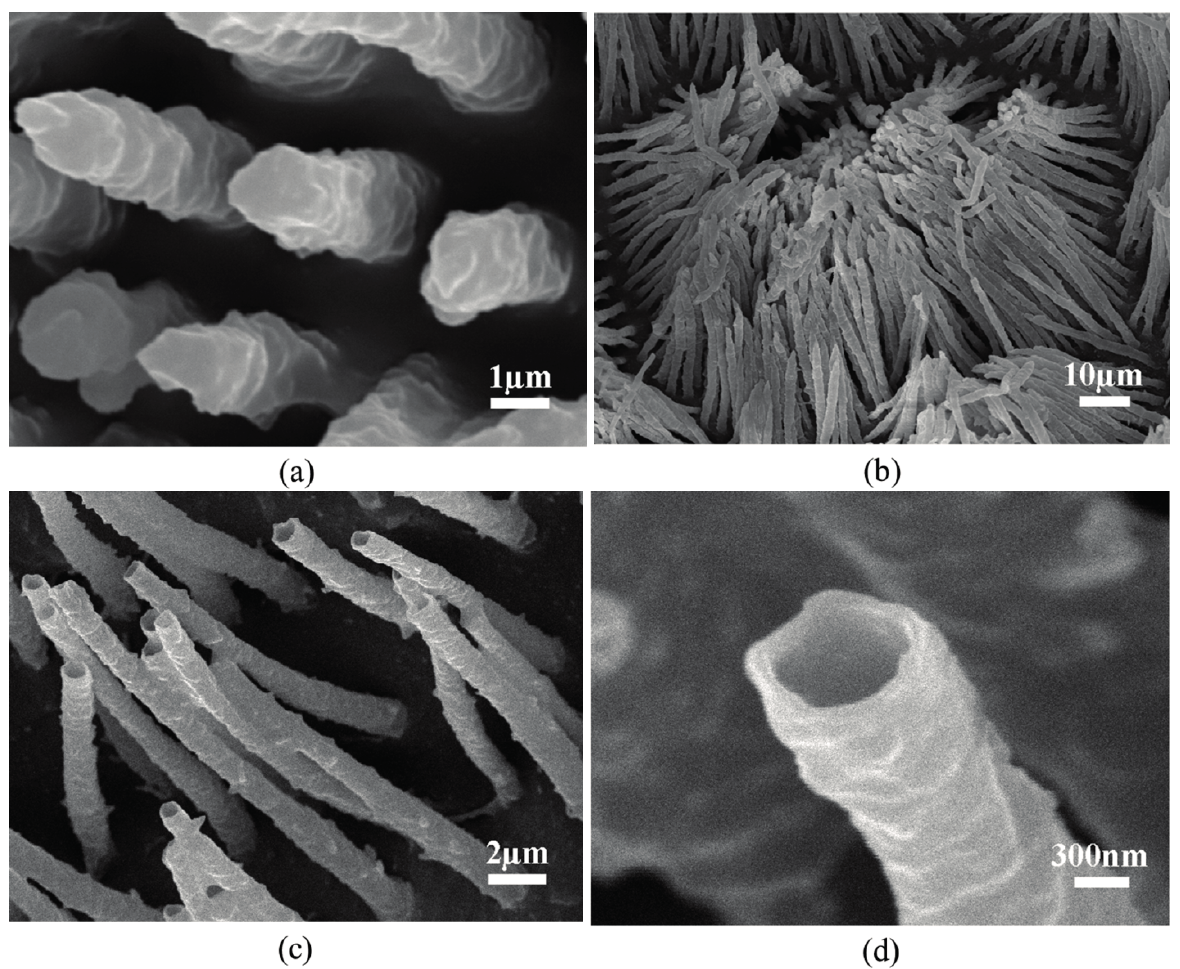
Figure 4. SEM images of the fabricated ( a , b ) micro-pillars and ( c , d )